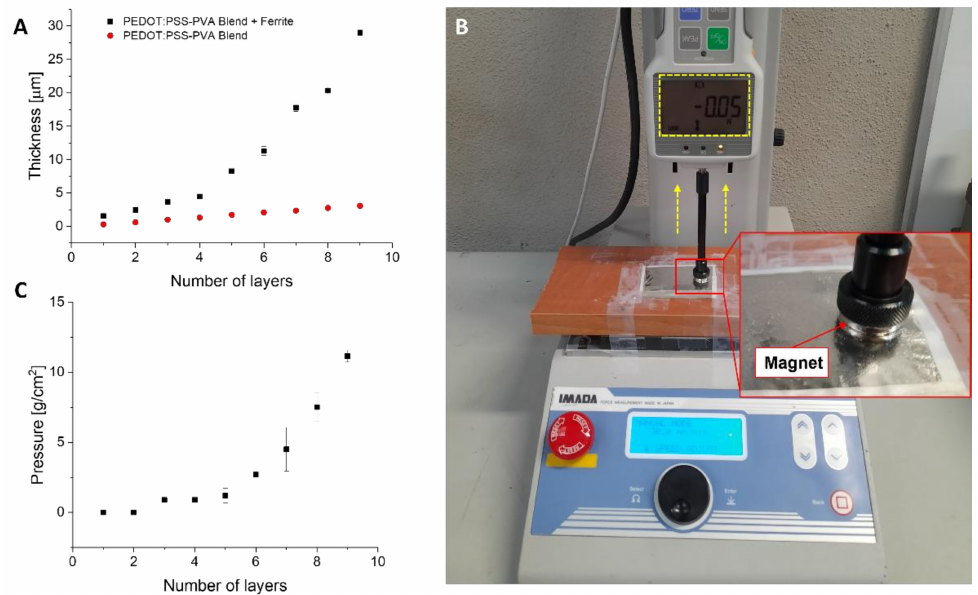
Figure 2. ( A ) Characterization of the thickness of both portions of the film with respect to the number of layers. ( B ) Setup for the measurement of the attractive force of interaction. ( C ) Quantification of the interaction (measured as g/cm 2 ) with respect to the number of